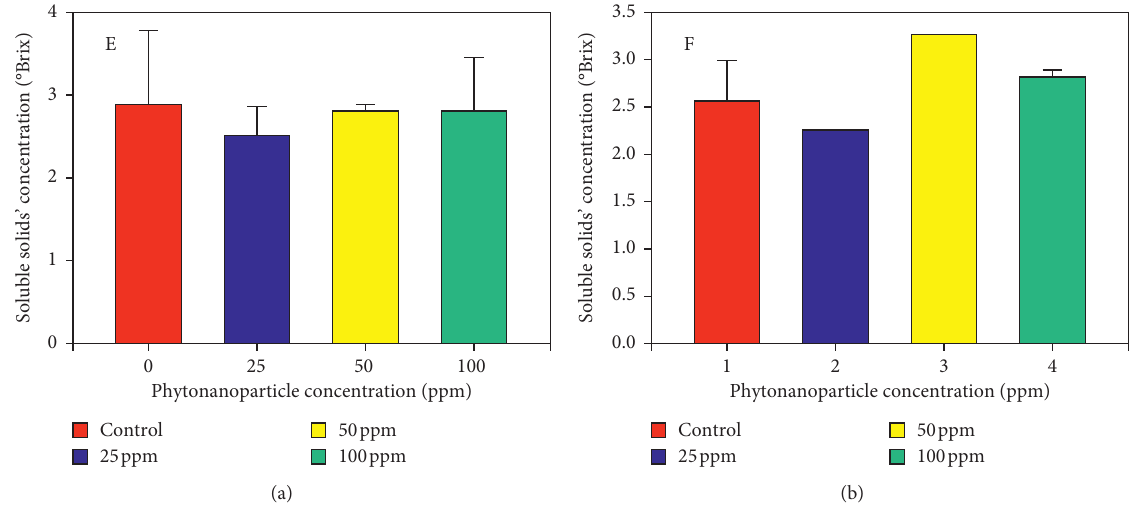
Figure 6: Quantification of total soluble solids in fruits of tomato plants ( Solanum lycopersicum ) in relation to the effect of ZnO phy- tonanoparticles with the Moringa oleifera extract. Mean of three repetitions with ( ± )standard error. Application: E: edaphic; F: